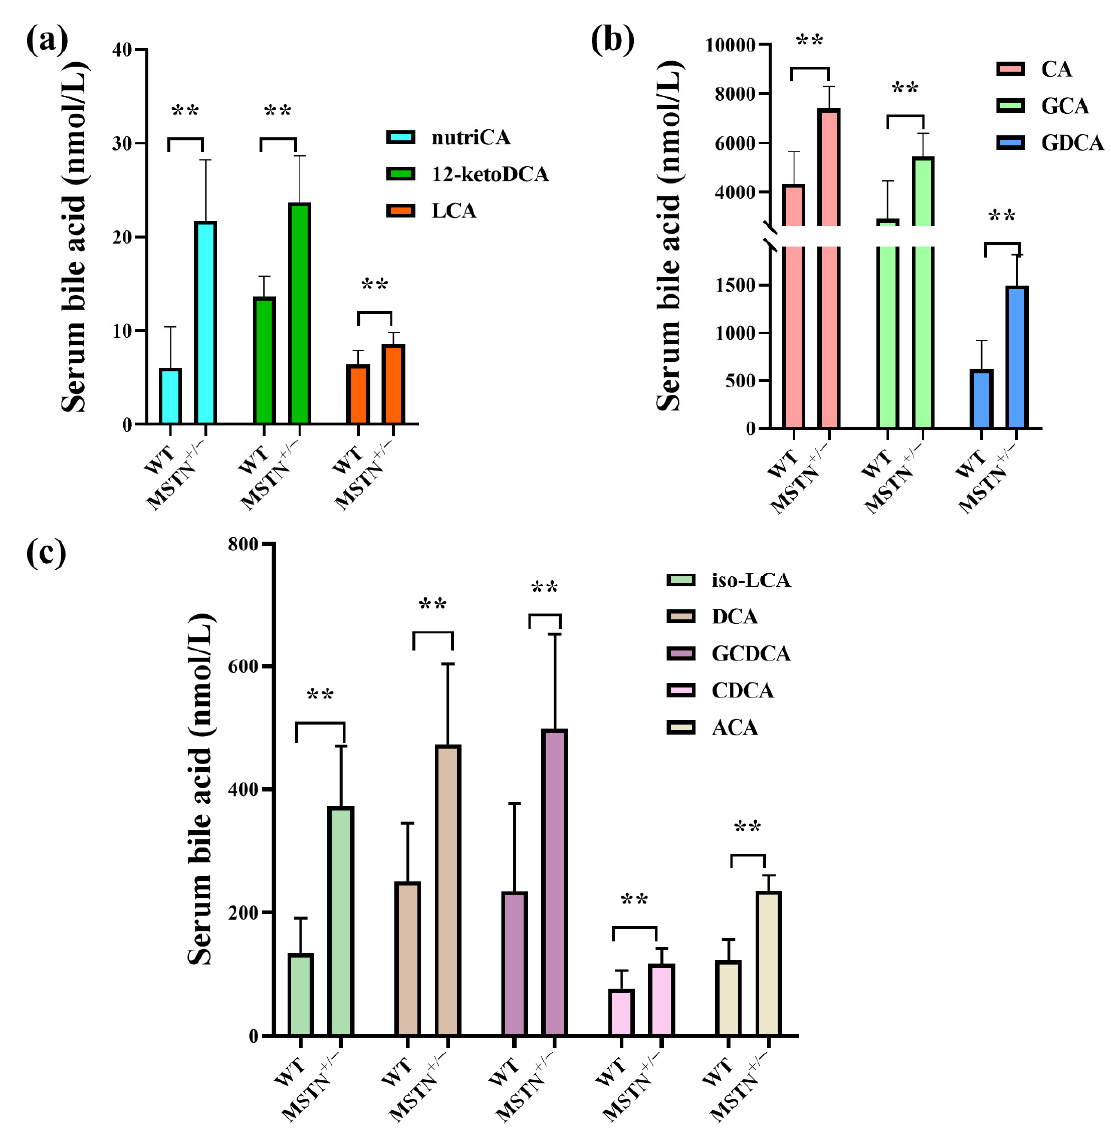
Figure 2. Targeted metabolomics analysis identifies the alteration of bile acids in serum of MSTN +/ − and WT cattle. ( a – c ) Differentially expressed bile acid species were identified. ** p < 0.01. WT, wild type; MSTN +/ − , MSTN heterozygous deletion. Abbreviations: nutriCA, nutritional cholic acid; 12- ketoDCA, 12-ketodeoxycholic acid; CA, cholic acid; GCA, glycol-cholic acid; GDCA, glycodeoxycholic acid; iso-LCA, isolithocholic acid; DCA, deoxycholic acid; GCDCA, glycol-chenodeoxycholic acid; LCA, lithocholic acid; CDCA, chenodeoxycholic acid; ACA, acetylcholic acid.